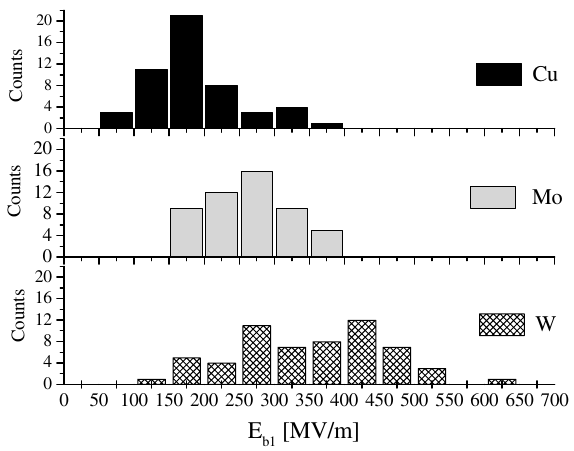
FIG. 4. Histograms of the breakdown field from various conditioning curves measured at different sites of the cathode for Cu, Mo, and W.